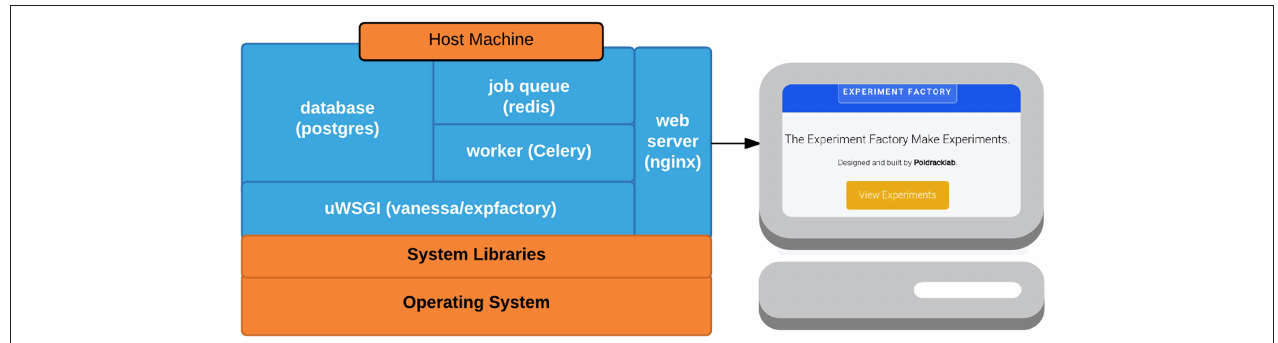
FIGURE 2 | Docker containers: Expfactory-docker includes the main application container (expfactory), a database for storing application data (postgres), a job queue (redis) and worker (Celery) for running computationally intensive tasks, and a web server (nginx) to serve the application to the